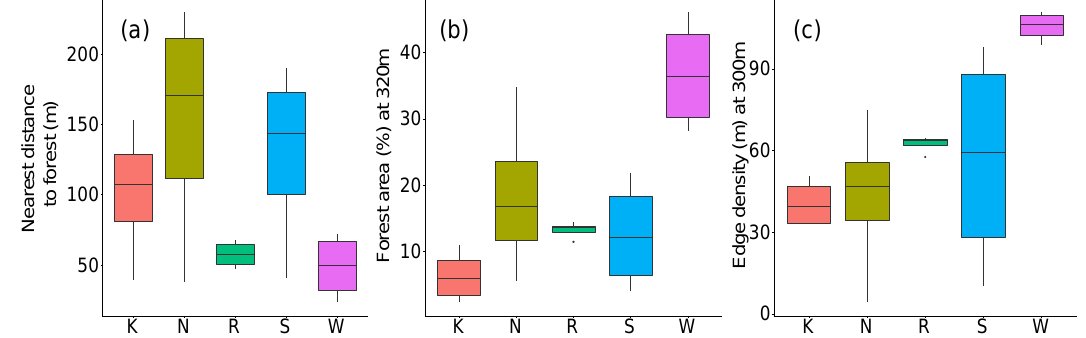
Figure 3. Distance to forest ( a ), forest area ( b ), and edge density ( c ) for the five orchards. Note the different ranges of the y